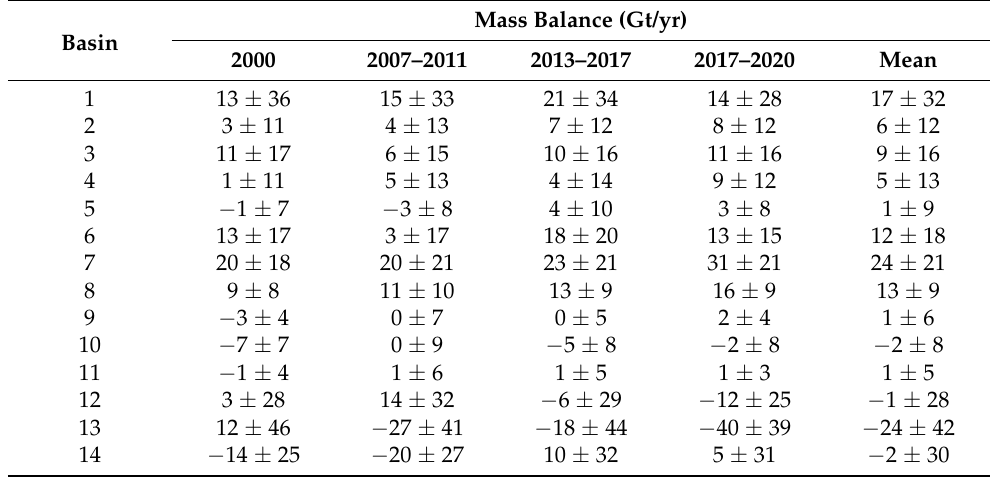
Figure 6. Comparison of annual SMB estimated from ERA5-Land and RACMO2.3 output. ( a ) The SMB of ERA5-Land against the SMB from RACMO2.3 in the AIS. ( b ) The SMB of ERA5-Land against the SMB from RACMO2.3p1 in the EAIS. ( c ) The SMB of ERA5-Land against the SMB from RACMO2.3p2 in the WAIS. ( d ) The SMB of ERA5-Land against the SMB from RACMO2.3p2 in the AP. Table 3. Mass balance in the four periods 2000, 2007–2011, 2013–2017, and 2017–2020 for the 27